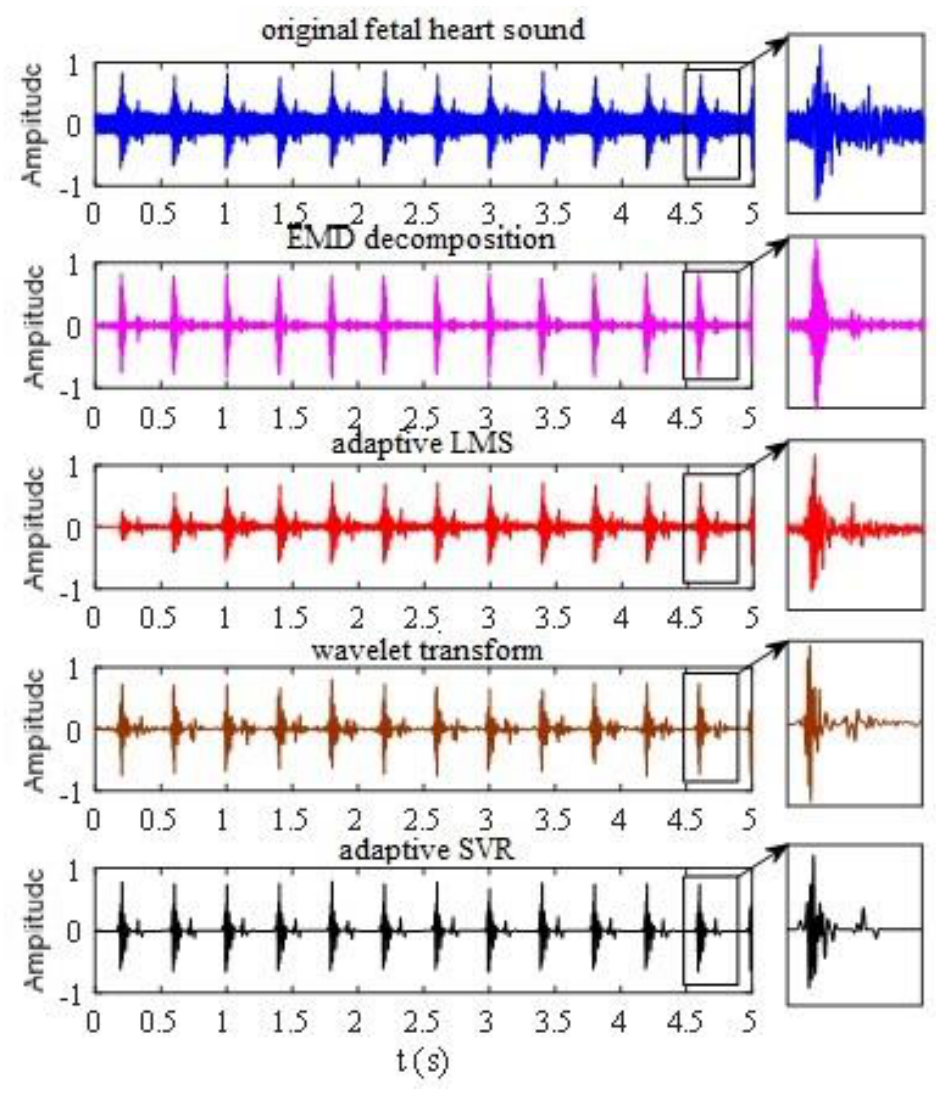
Figure 6. Comparison of noise reduction of the four algorithms.